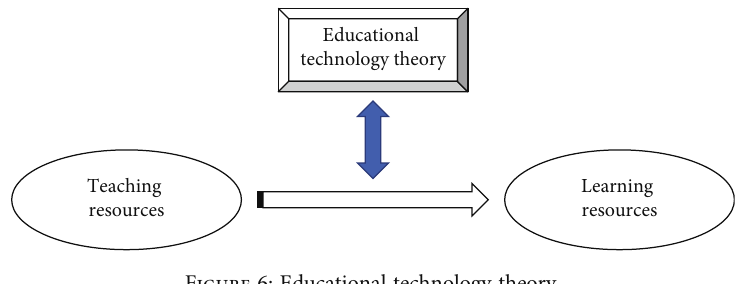
Figure 6: Educational technology theory.